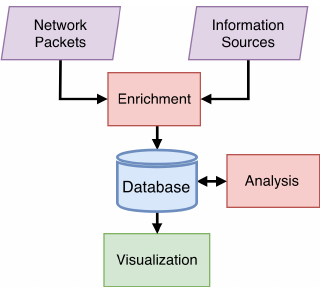
Figure 1. Data-flow